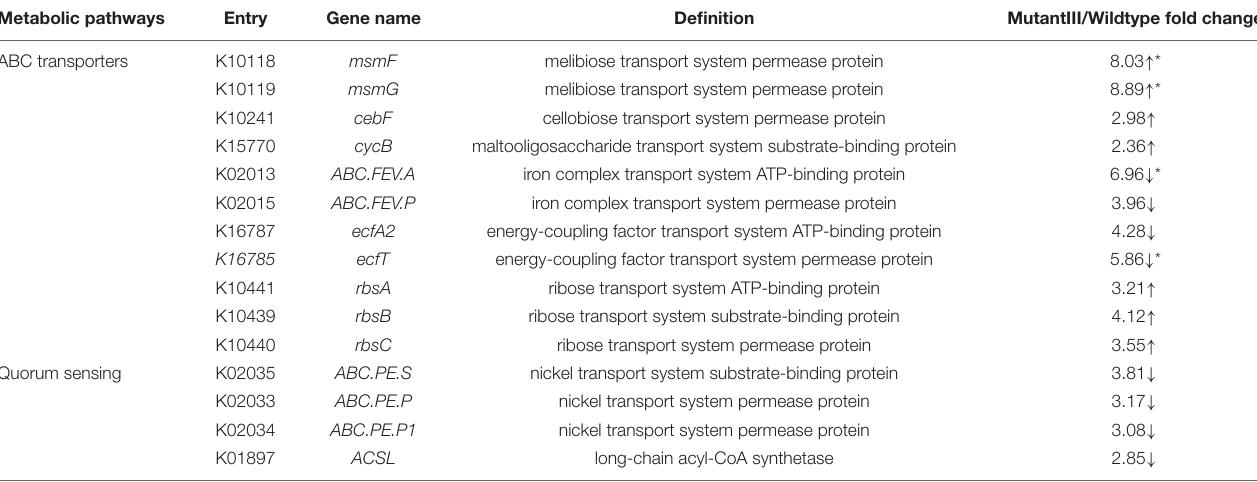
TABLE 2 | Differential expression genes related to ABC transporters and quorum sensing. Metabolic